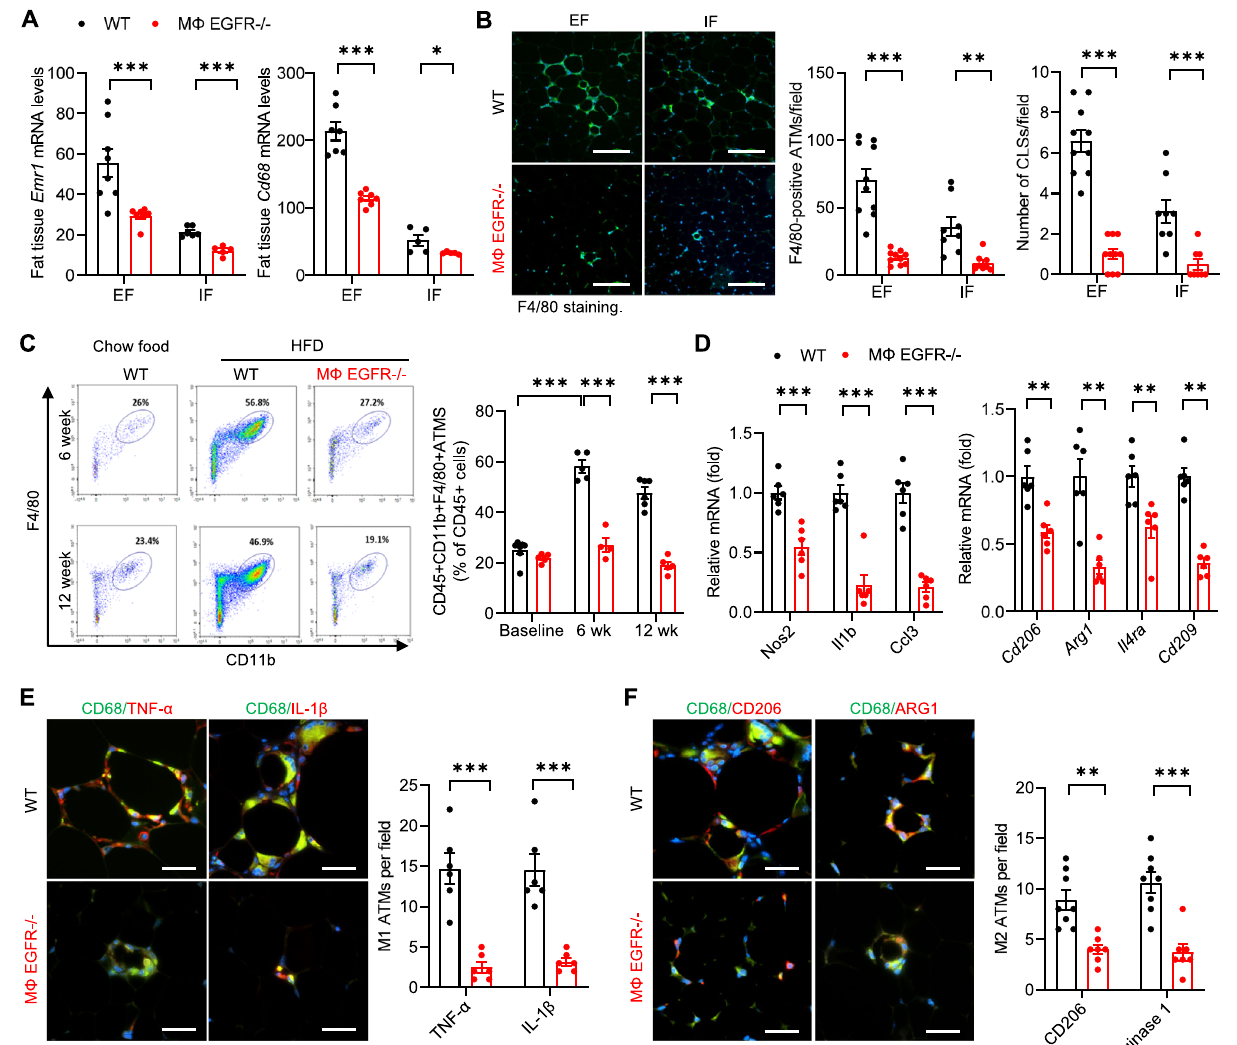
Fig. 6 | Myeloid EGFR − / − mice had less ATM accumulation and lower proin- fl ammatory cytokines/chemokine in diet-induced obesity. WT and M Φ EGFR − / − mice were fed the HFD for 6 and 12 weeks. A M Φ EGFR − / − mice hadlower Emr1 (F4/ 80) ( N =5 and 8) and Cd68 ( N =5 and 8) expression in both EF and IF compared to WT mice at 12 weeks after the HFD. B Quantitative F4/80 staining demonstrated fewer ATMs and CLSs in both EF and IF in M Φ EGFR − / − mice than WT mice at 12 weeks after the HFD. N =8 and 10, scale bar=200 μ m. C Flow cytometry con- fi rmed less EF CD45 + CD11b + F4/80 + ATMs at both 6 and 12 weeks after the HFD in